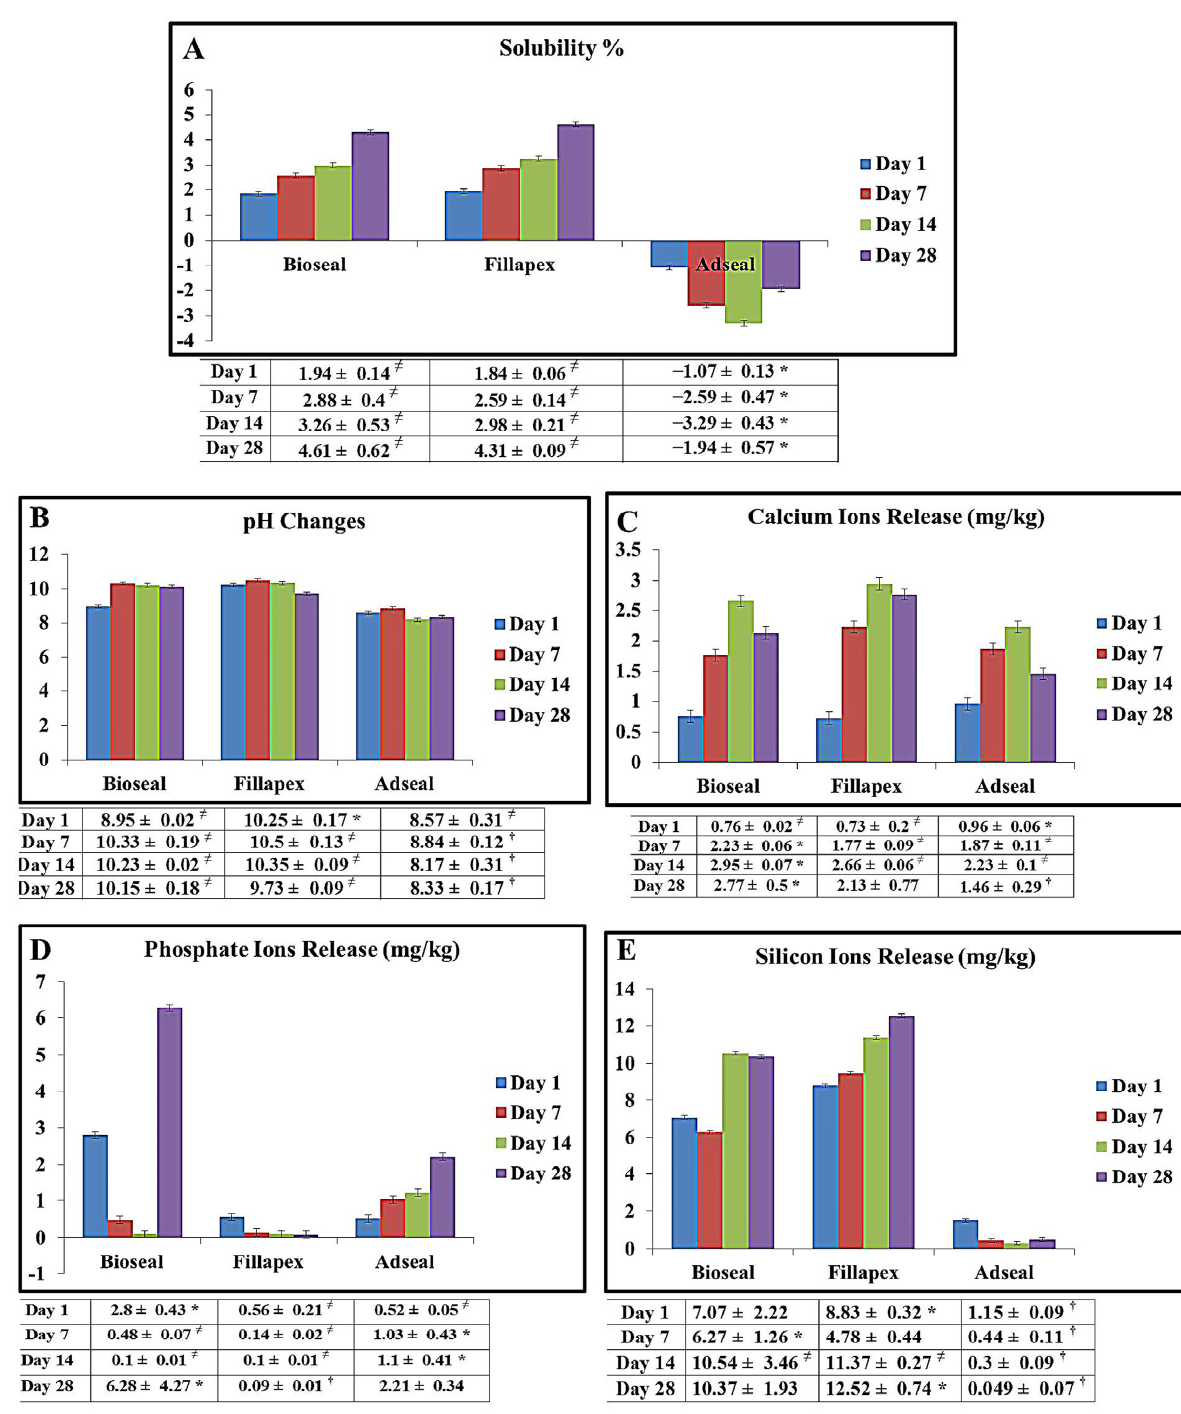
Figure 2. Histograms representing the mean values of solubility % ( A ), pH changes ( B ), Ca 2+ ion release ( C ), PO 4 3 − ion release ( D ), and Si 4+ ion release ( E ) of the root canal sealers over the immersion times of the experiment. * indicates the highest significant value (at p < 0.001). † indicates the lowest significant value (at p < 0.001). ≠ indicates no significant dif- ference between sealers of the same symbol ( p > 0.05).